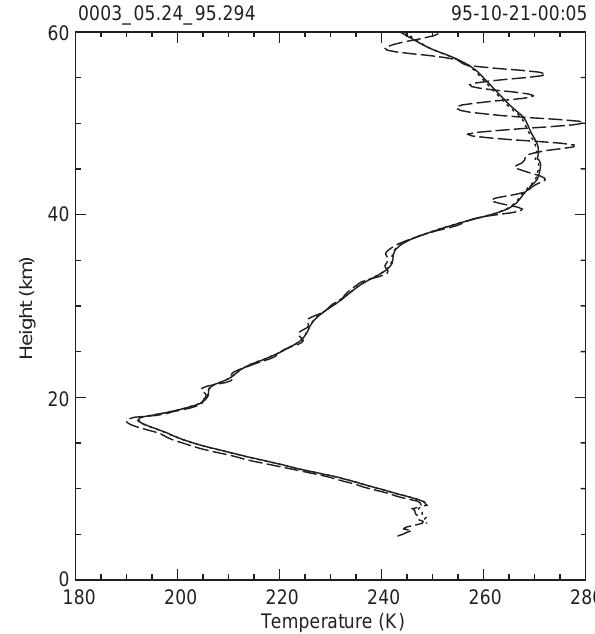
Fig. 5. The topic of height sampling in matrix inversion retrieval is illustrated by comparing three temperature profiles with di(cid:128)erent layer thicknesses adopted, all corresponding to the same occultation event 1 on October 21, 1995, 00:00 UT, located at 38.2 (cid:176) N and 139.2 (cid:176) E. Profiles obtained with layer thicknesses (in the upper stratosphere) of about 400 m ( dashed line ), 200 m ( solid line ), and 100 m ( dotted line ) are shown